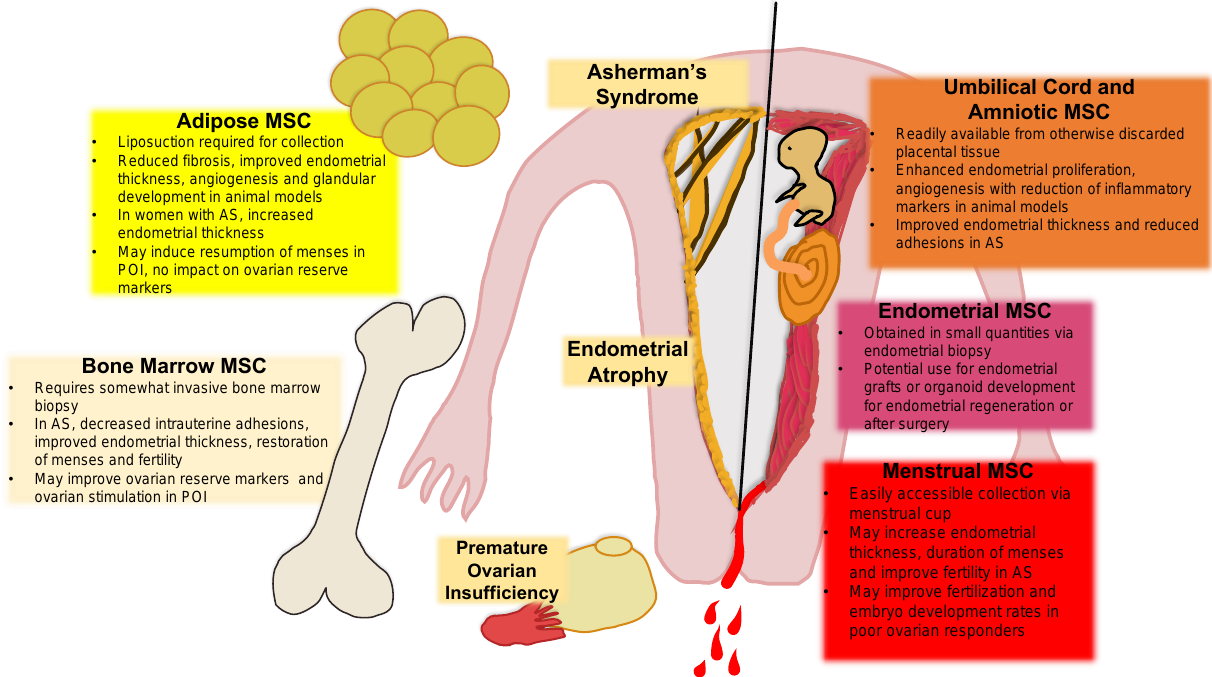
Figure 1. Sources of mesenchymal stem cells and implications for treatment of endometrial and ovarian-related infertility. This figure describes the various potential sources of mesenchymal stem cells including their collection and described therapeutic effects. The solid black line delineates physiologic endometrium (right) from pathologic endometrial environment (left). AS = Asherman’s Syndrome; MSC = Mesenchymal Stem Cell; POI = Premature Ovarian In sufficiency.